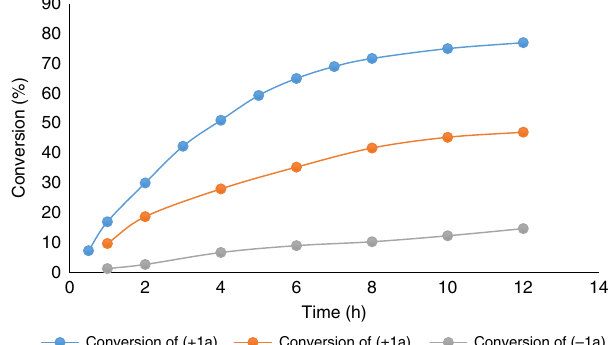
Fig. 4 Kinetic pro fi le. The reaction with ( + )- 1a was faster than that of ( − )- 1a .